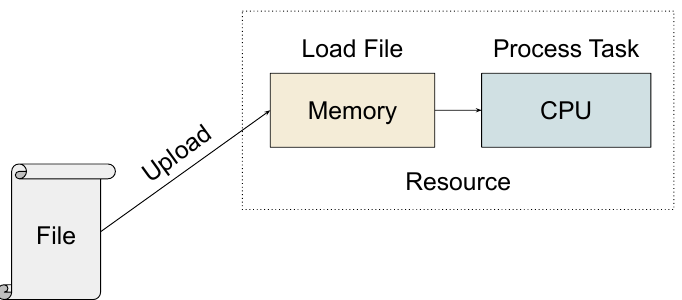
Figure 2. Execution flow of a read task on a computational